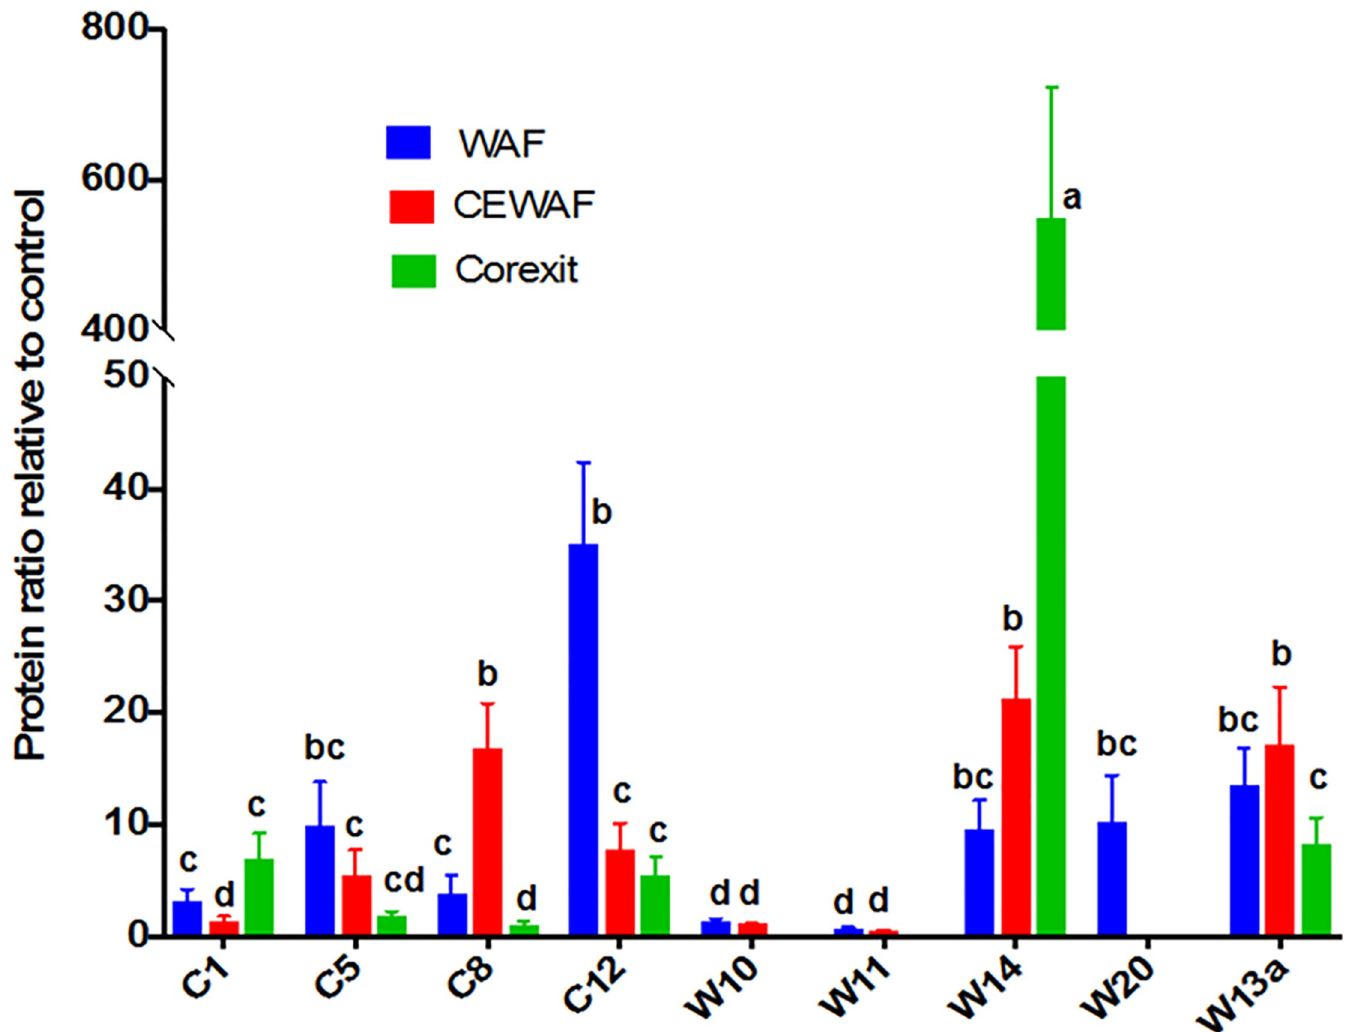
Fig 2. Production of protein by the isolates in WAF, CEWAF and Corexit after 4 d of incubation. All values are normalized to Control. Error bars represent the standard deviation of the replicates. Different letters above bars indicate significant differences among treatments (P < 0.05).